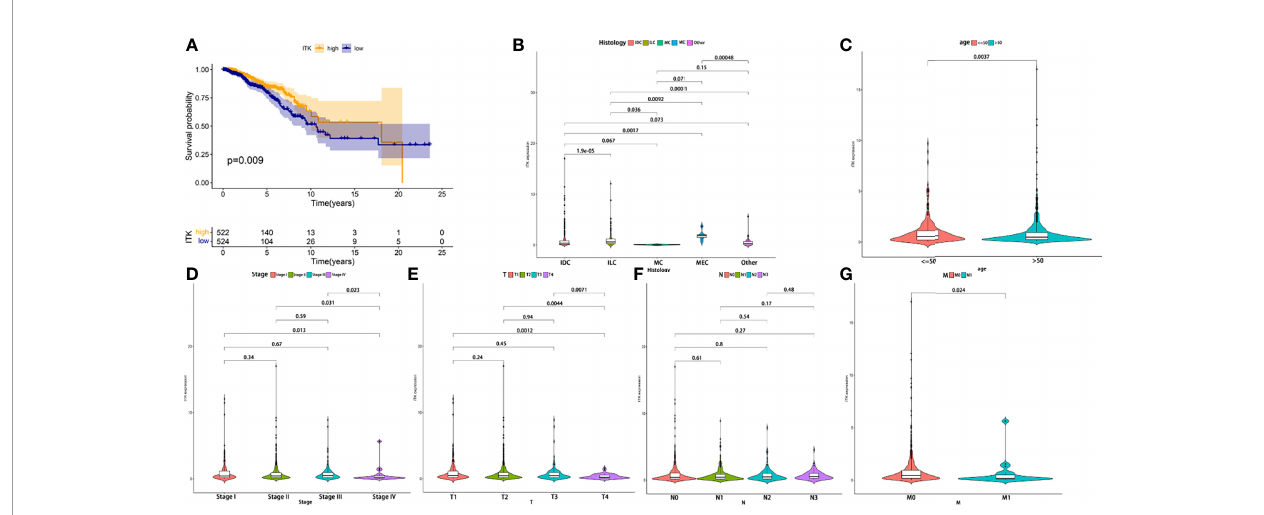
FIGURE 6 | The correlation in the expression of ITK with the survival time and clinical characteristics. (A) The Kaplan – Meier survival analysis conducted for ITK expression. Comparisons were performed in the high expression and low expression groups and presented in orange and blue, respectively. (B – G) Comparison of ITK expression in histology, age, and TNM staging. IDC, In fi ltrating Ductal Carcinoma; ILC, In fi ltrating Lobular Carcinoma; MC, Mucinous Carcinoma; MEC, Medullary Carcinoma.